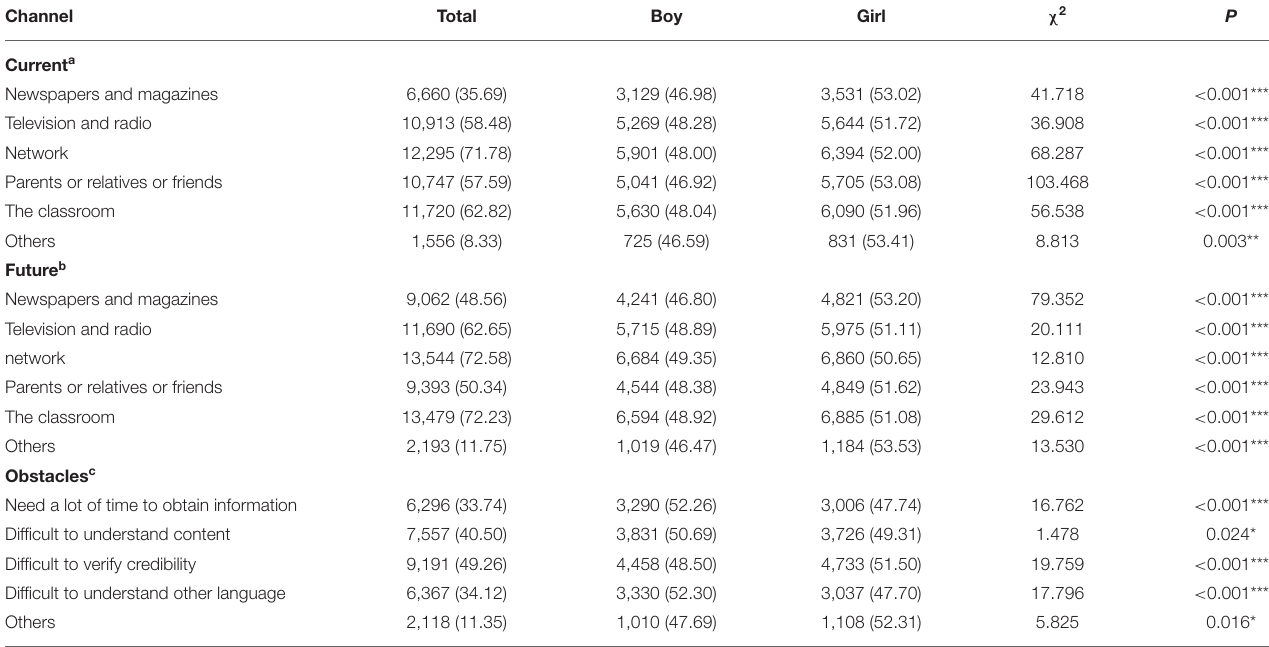
TABLE 2 | Channels and obstacles of nutrition information obtained by gender N (%). Channel Total Boy Girl χ 2